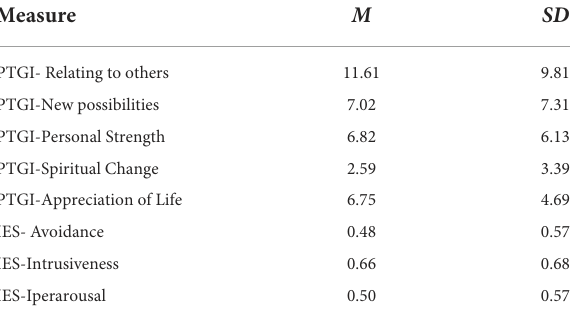
TABLE 2 Descriptive statistics of the IES-R and PTGI sub-scales (mean +